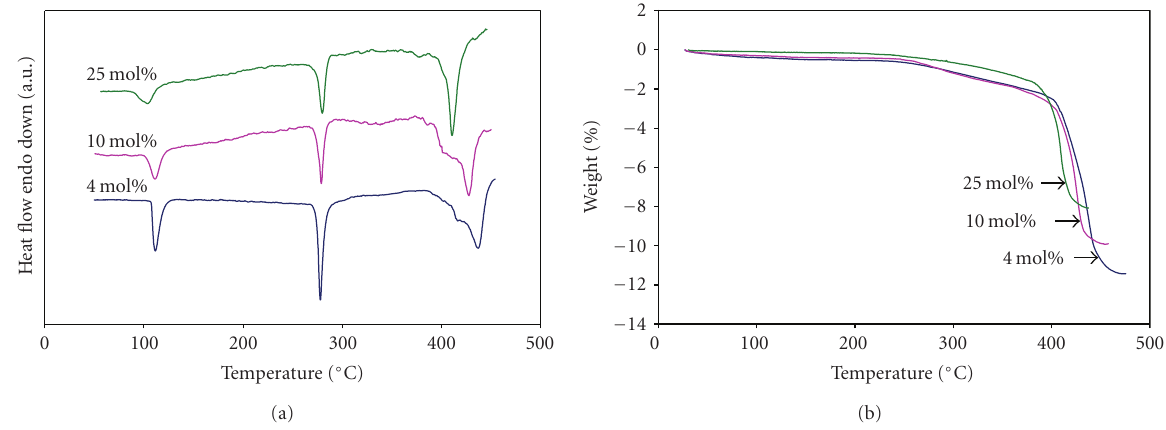
Figure 2: (a) DTA and (b) TGA curves of the LiBH 4 /CaH 2 mixture with 4, 10, and 25mol% of TiCl 3